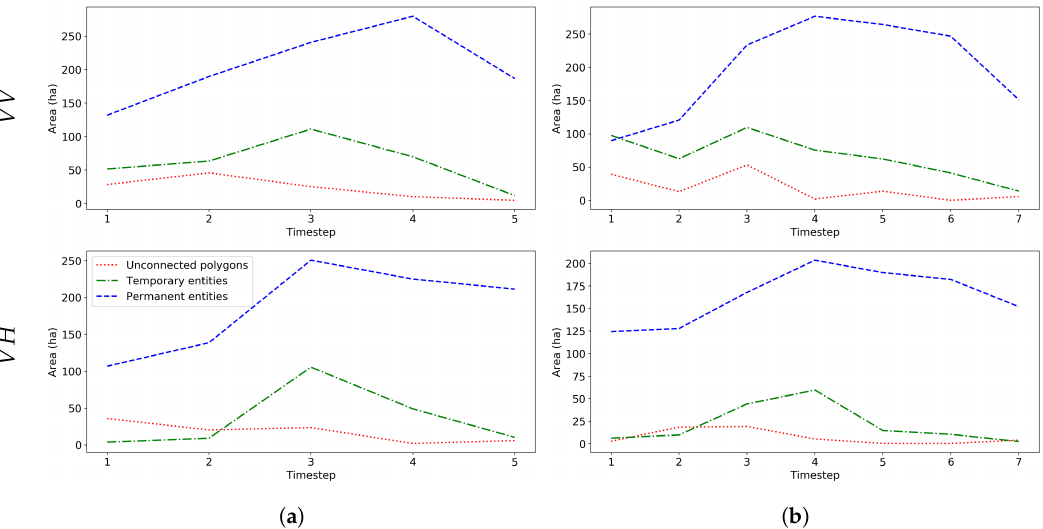
Figure 6. Area evolution of unconnected polygons, temporary entities, and permanent entities. ( a ) Ascending time series. ( b ) Descending time